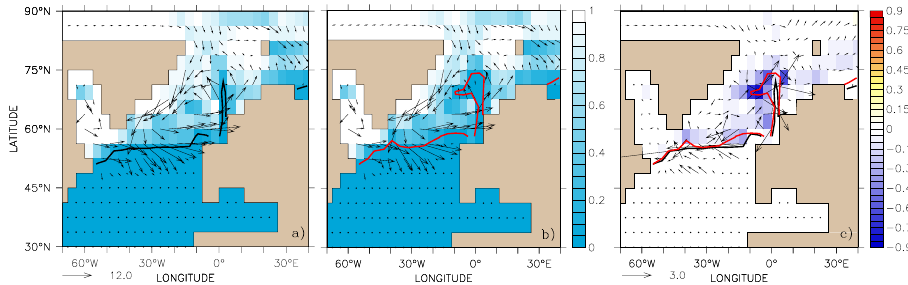
Fig. 6. Sea-ice fraction (shaded) and sea-ice velocities (vectors) in cms − 1 during summer (June–August) for the CO 2 -only scenario in (a) the stadial state; (b) the transition state; (c) transition minus stadial state. Black and red lines show the locations of the 90% northern summer (June–August) average sea ice concentration for the stadial and the transition stage, respectively.